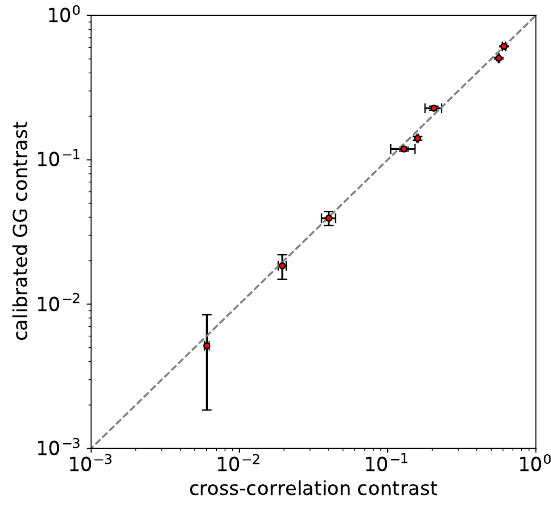
Figure 4. Comparison of the contrasts extracted from the cross-correlation of the neighboring frames and the calibrated contrasts using the GG photon assignment algorithm. The dashed line is a guide of the eye denoting when the two methods perfectly